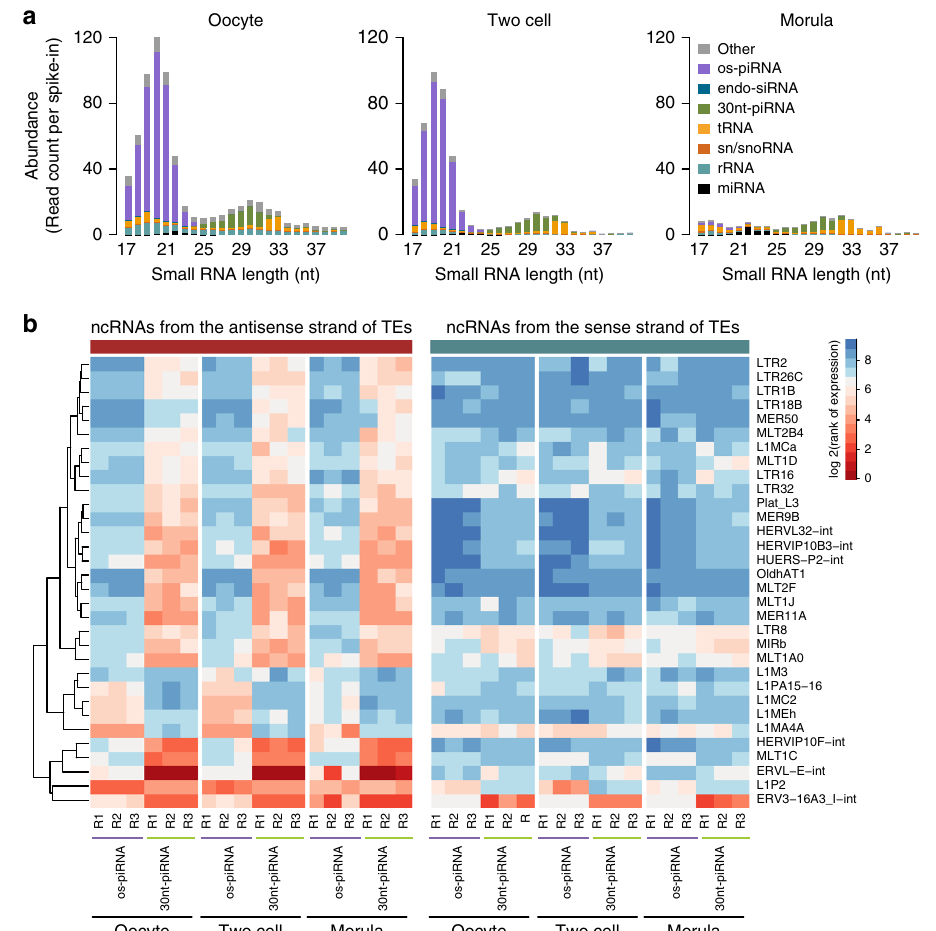
Fig. 6 Expression of small RNAs in human early embryos. a Abundance and length distribution of small RNAs in human oocytes and early embryos. The expression of small RNAs was normalized to an exogenous spike-in. b The highly expressed transposable elements (TEs) that were differentially regulated by oocyte short-PIWI-interacting RNAs (os-piRNAs) and the 30-nt piRNAs in human oocytes are shown. The TEs were ranked in descending order based on the relative abundance of their corresponding piRNAs. The expression ranks of os-piRNAs and the 30-nt piRNAs from the antisense strand of each TE were analyzed by a t test (false discovery rate (FDR) ≤ 0.05). Only the top 50 TEs that were targeted by os-piRNAs or the 30-nt piRNAs were included. Source data of a , b are provided in the Source Data fi